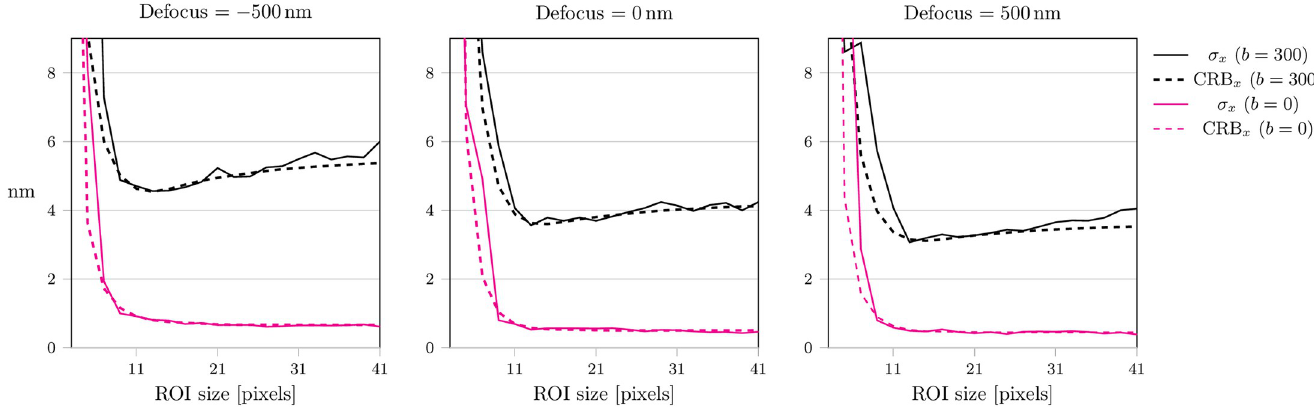
Fig 6. Influence of the size of the fitted region. Precision (solid lines) and CRB (dashed lines) are shown for fitted regions of interest ranging from 3 pixels to 41 pixels. Simulations were carried out for two different noise levels, b = 0 (pink lines) and b = 300 (black lines) and for three different defocus values. The inclination angle was set to θ = π /6. A list of all simulation parameters is given in S1 Table in S1 File.